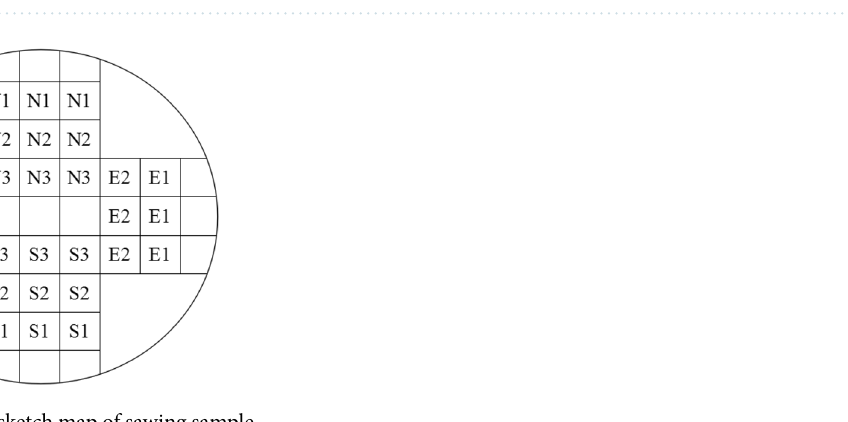
Table 5. The geographical and climate conditions of sampling sites. Sn is the number of test material samples, Pro is the name of province, SA is the average age of stand, SD is the stand density, Long is longitude, Lat is latitude, Alt is altitude, MAT is mean daily average temperature, MAP is the mean annual precipitation.